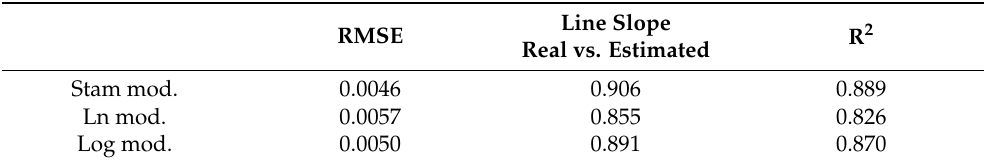
Line Slope RMSE Real vs. Estimated